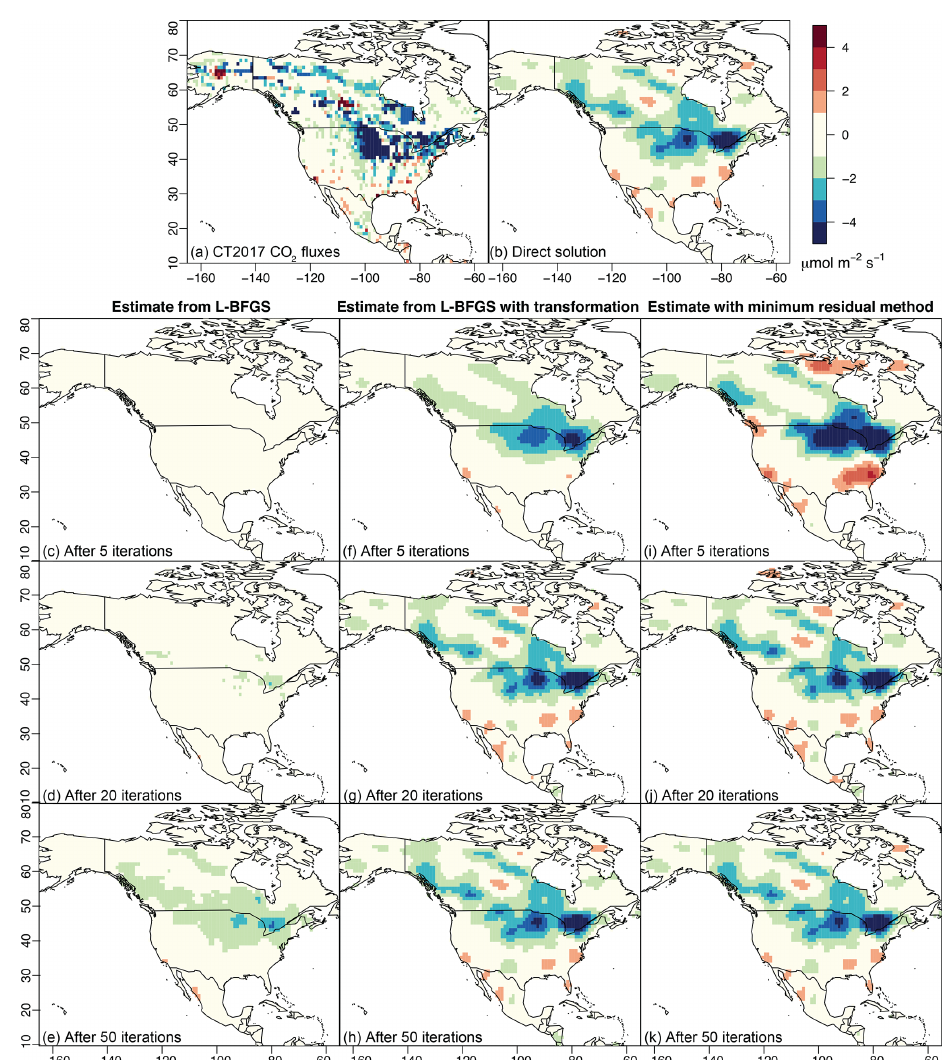
Figure 2. The “true” CO 2 fluxes from CT2017 used in the 6-week case study (a) and the direct estimate of the fluxes (b) . We estimate 3-hourly fluxes but average them across the month of July in this figure. Panels (c–e) display the flux estimate from L-BFGS as a function of iteration number, panels (f–h) those from L-BFGS with a variable transformation, and panels (i–k) those from the minimum-residual approach. Both L-BFGS with the transformation and the minimum-residual approach resemble the direct solution after about 20 iterations (panels d , g , and j